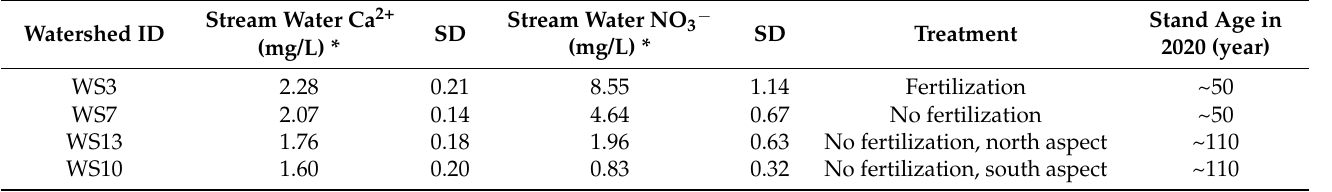
* Values are based on weekly grab samples taken upstream of the weirs. Stream water chemical analyses were conducted at the USDA Forest Service’s Timber and Watershed Laboratory in Parsons, WV, using EPA—approved protocols. Sampling and analysis methods are described in Adams et al. [40]; data available at [74]. For this table, weekly values were first averaged for each year and then averaged over the 25-year